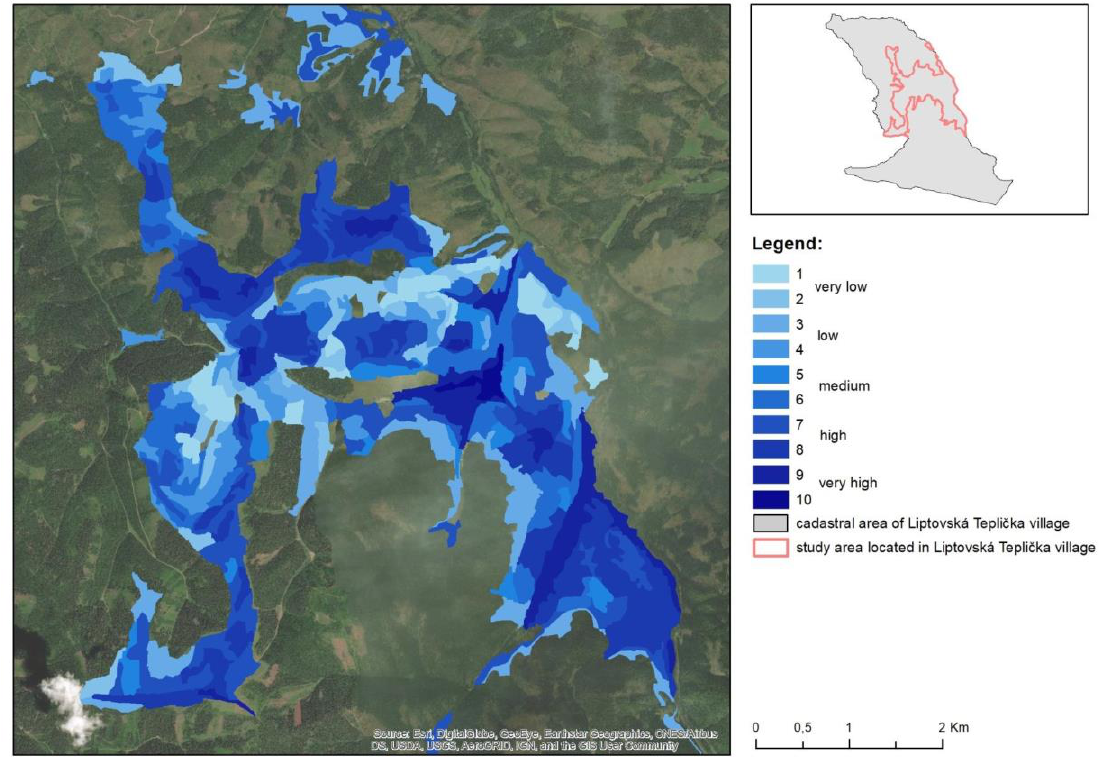
Figure 5. Soil water retention capacity (SWRC). Source: Base map, Esri, 2020.